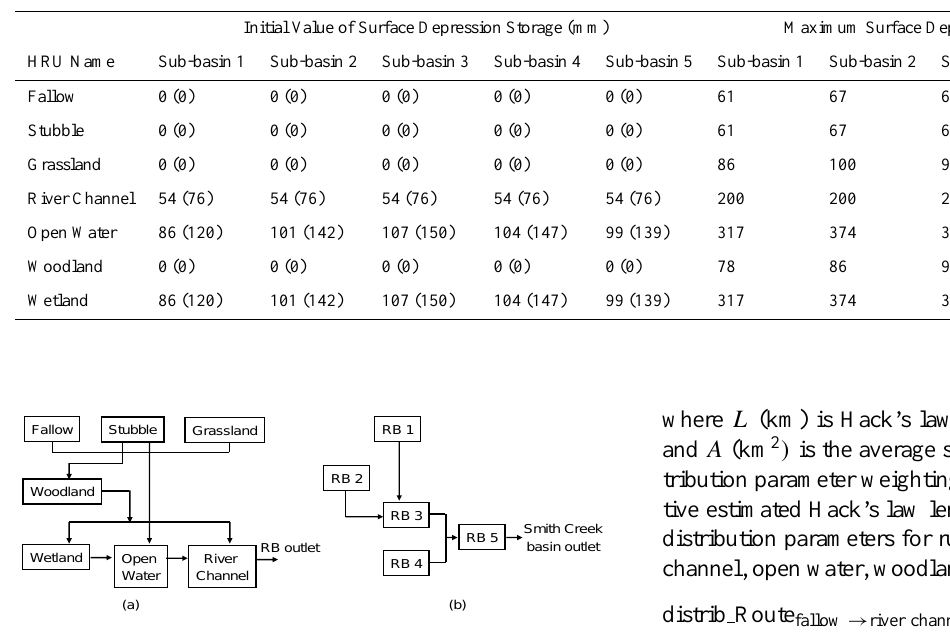
Fig. 6. (a) Rouing sequence between HRUs within the sub-basin (RB) and (b) routing sequence between